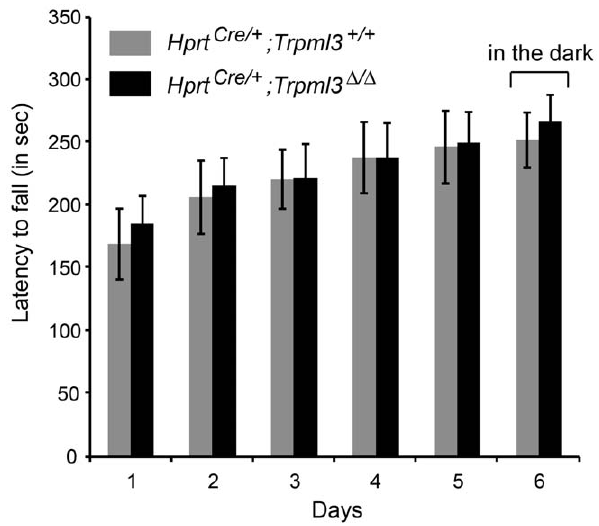
Figure 5. Rotarod experiments. The average latencies to fall 6 SEM (in sec) are shown for 3-month-old Hprt Cre/ + ;Trpml3 + / + (n=8) and Hprt Cre/ + ;Trpml3 D / D (n=8) mice. The experiment was executed over a time range of 6 days. The day 6 experiment was performed in the dark to exclude compensation via visual cues. The difference between genotypes was not statistically significant at any given time point (p . 0.05, one-way ANOVA, followed by Tukey’s post test).